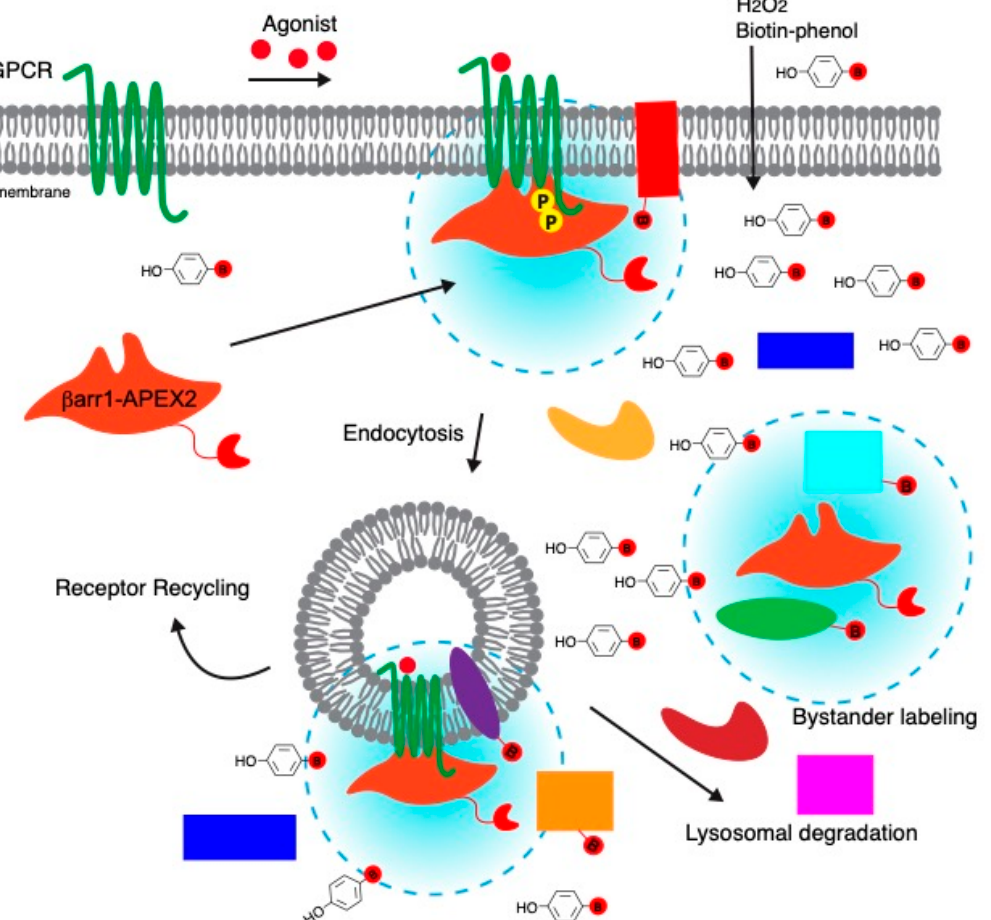
Figure 1. Schematic representation of biotinylation of proximal proteins by β -arrestin1-APEX2 ( β arr1-APEX2). β arr1-APEX2 transiently expressed in HeLa cells is mainly diffusely distributed in the cytoplasm under basal conditions. Upon agonist stimulation, β arr1-APEX2 is recruited to ligand-activated and phosphorylated (yellow circle) GPCRs at the plasma membrane and/or endosomes after internalization. After adding biotin-phenol and hydrogen peroxide to the cells, APEX2 rapidly biotinylates proteins proximal to β arr1-APEX2 within a labeling radius of approximately 20 nm. Receptor-bound β arr1-APEX2 is expected to spatially and temporally label proteins at the plasma membrane and/or endosomes. Non-receptor-associated β arr1-APEX2 that remains in the cytosol, similar to APEX2, will label bystander proteins that are located within a 20- nm labeling radius. The labeling radius is indicated by a dotted circle. Proteins within the circles are labeled with biotin (B), and proteins outside of this range are not expected to be labeled. Labeled proteins can be selectively purified by streptavidin-pulldown and analyzed by immunoblotting and/or mass spectrometry.